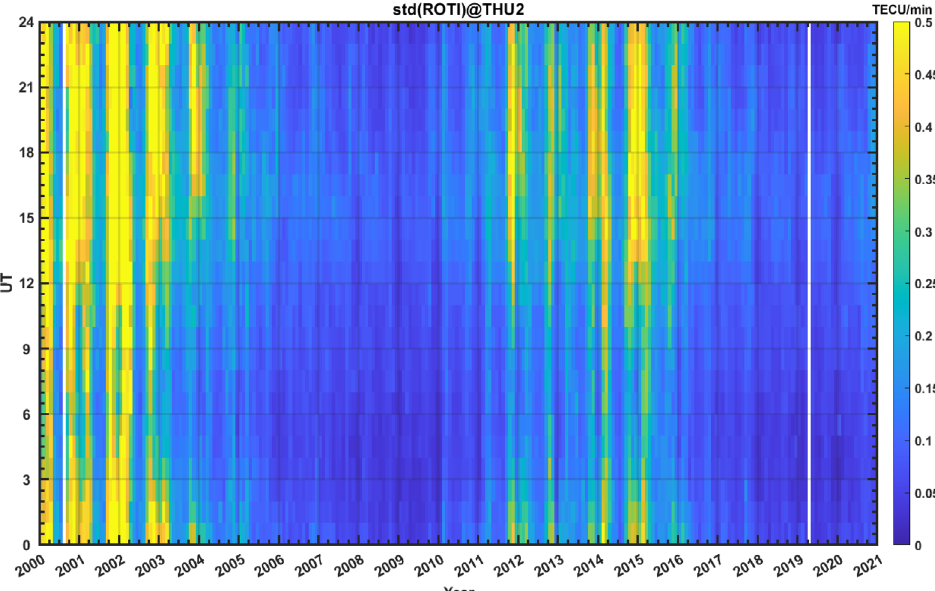
Fig. 11. The standard deviation (std) of ROTI in bins of 1 h by 1 month. It is clear that the variations of std (ROTI) also show solar cycle, seasonal, and diurnal variations in the same manner as the climatology of mean